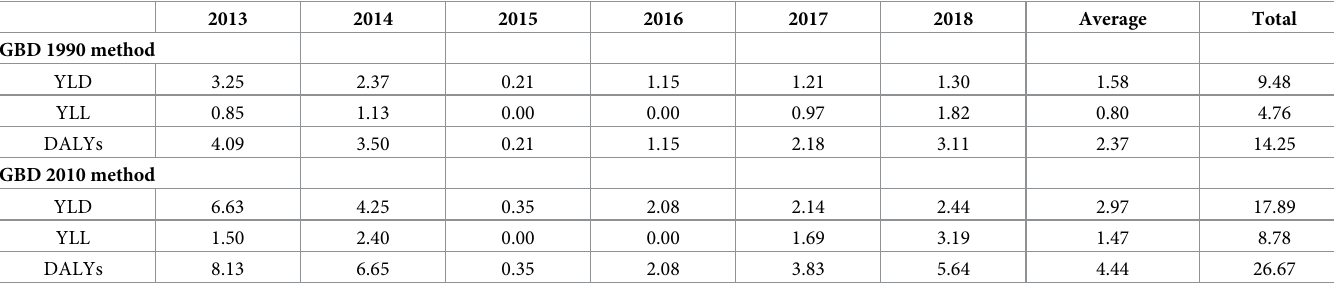
Table 4. Estimate disease burden of 149 reported Japanese encephalitis cases in Zhejiang Province per million population,